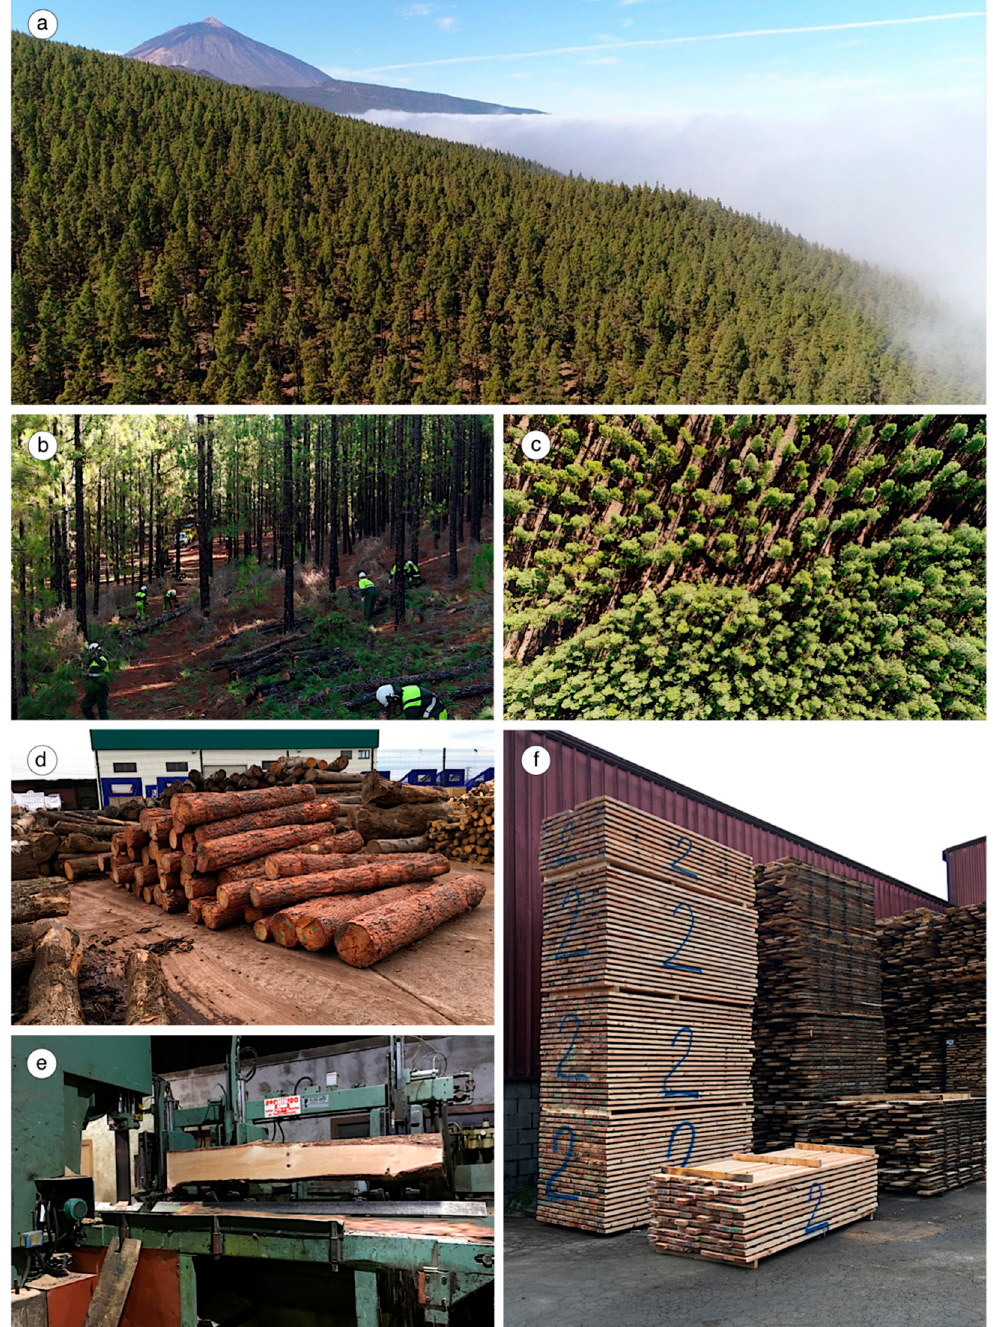
Figure 3. Sample collection. ( a ) Canary Island pine forest on the north slope; ( b ) plantation thinning tasks; ( c ) plantation with and without thinning; ( d ) boles in the sawmill yard; ( e ) sawing boles; ( f ) stacks of sawn timber from log 2.